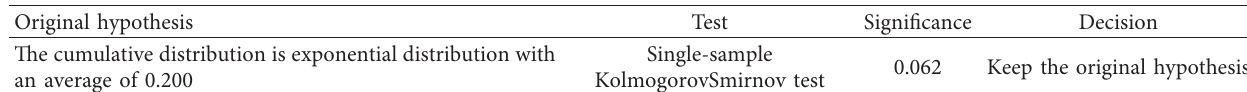
Table 2: Summary of hypothesis tests.